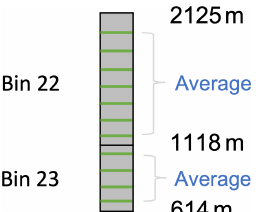
Figure 3. Sketch map of WPR and AUX_MET wind conversion to Aeolus range bins, where green bars represent the heights of WPR or AUX_MET